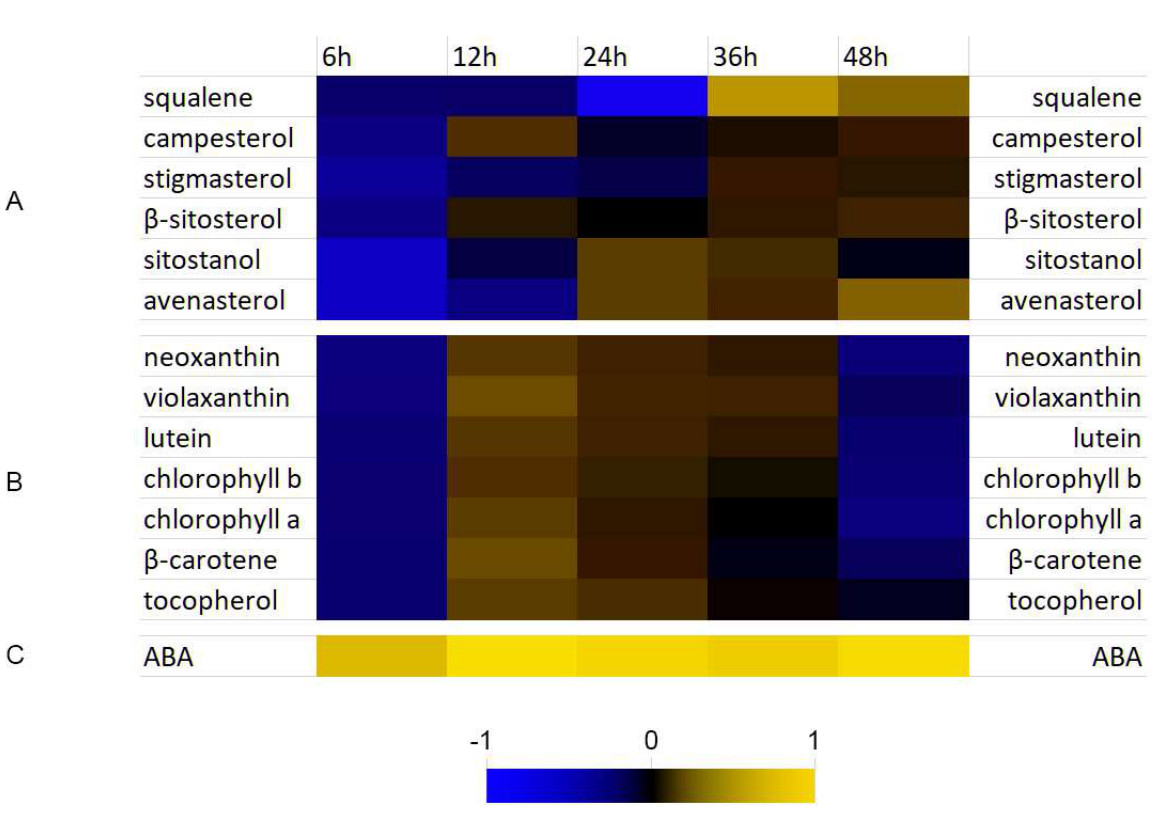
Figure 4. Heatmap of terpenoid metabolites in flax after F. culmorum infection (x–fold of the control). ( A )—phytosterols; ( B )—carotenoids; ( C )—ABA. Detailed results on the expression can be found in Supplementary File S4.